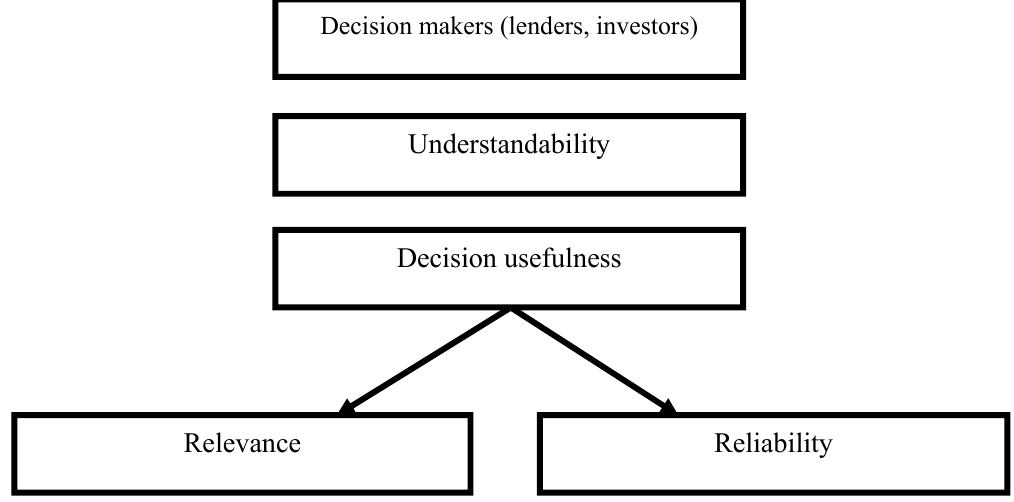
Fig. 1. Financial reporting quality